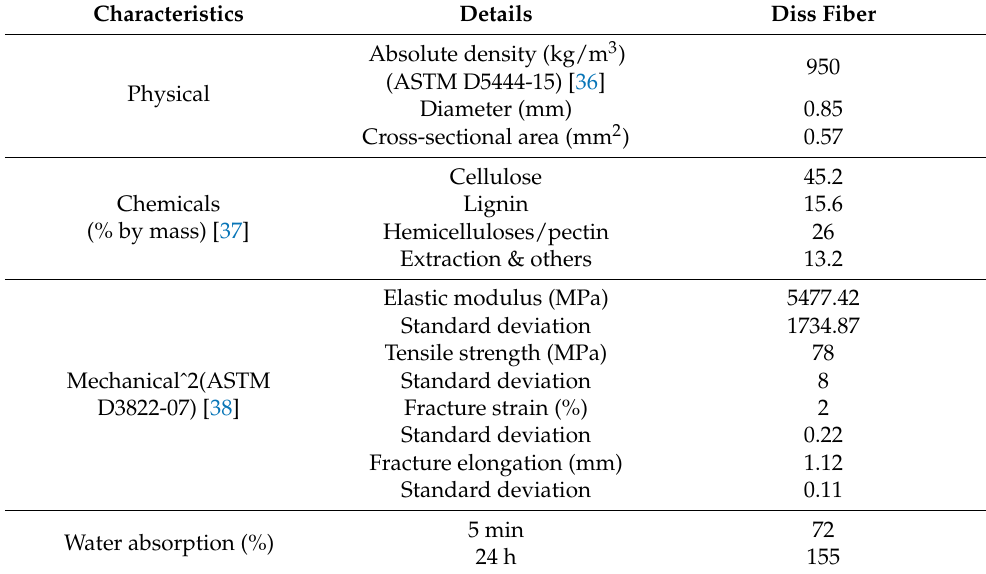
Table 3. Characteristics of Diss fibers.